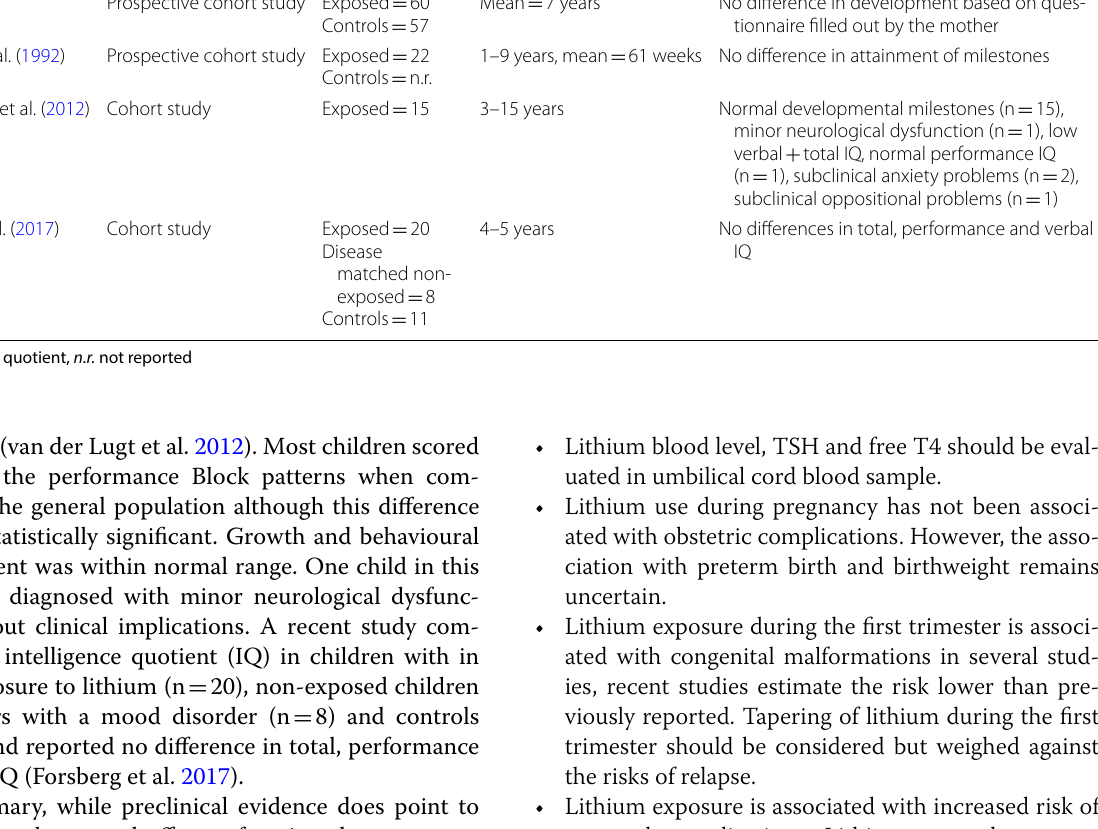
Table 4 Neurodevelopmental consequences of intrauterine exposure to lithium: findings from clinical cohort studies